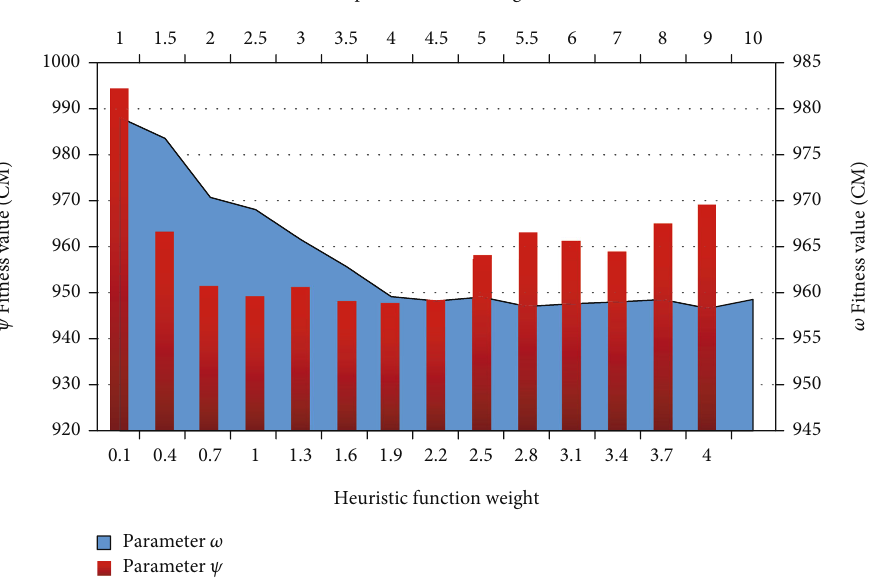
Figure 5: In fl uence of weight parameters of optimization ant colony algorithm on target